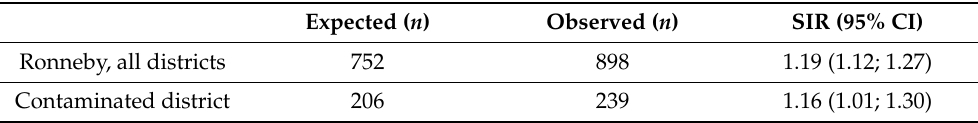
Table 2. Standardized incidence ratios (SIR) and associated 95% confidence intervals (CI) of verified COVID-19 in Ronneby, all districts together, and in the contaminated district in relation to the reference